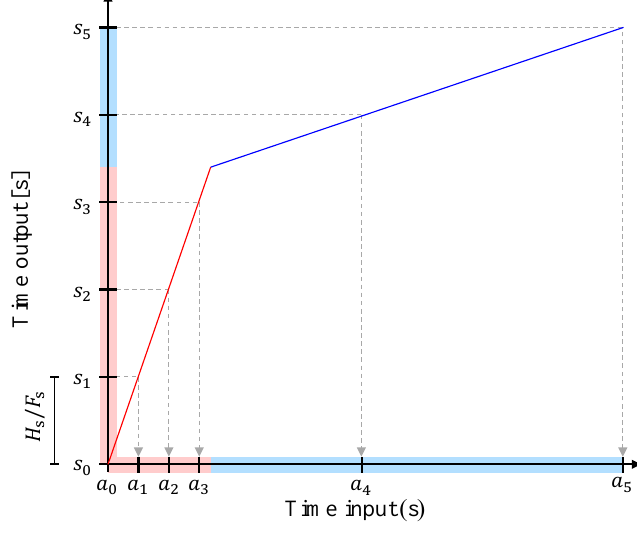
Figure 14. Example of a non-linear time-stretch function τ